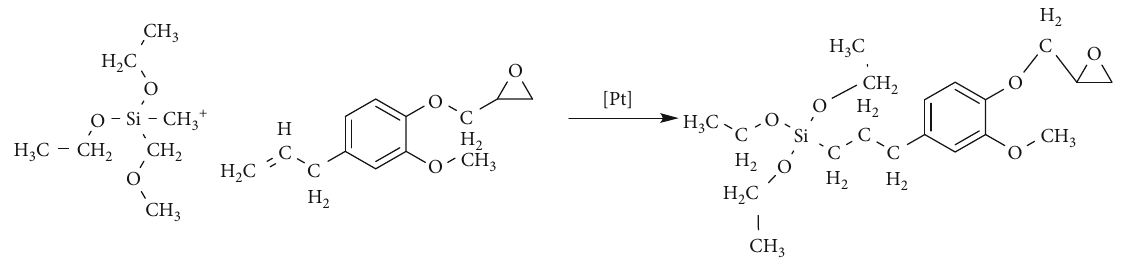
-MoS core-shell 2 2